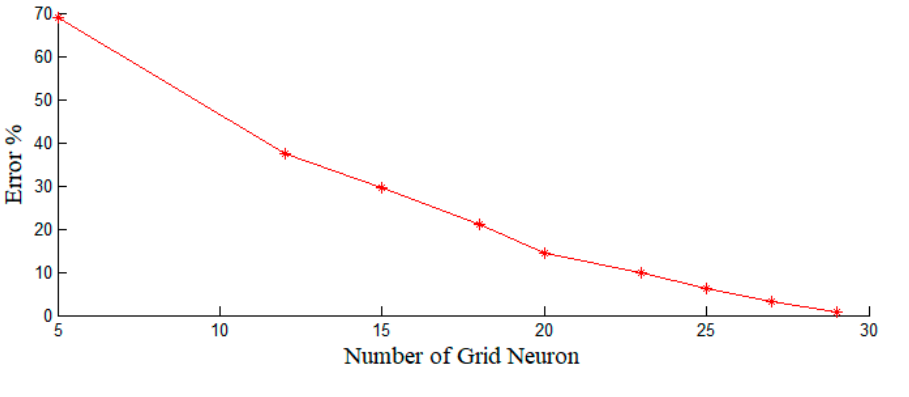
Figure 22. Error in self-localization.